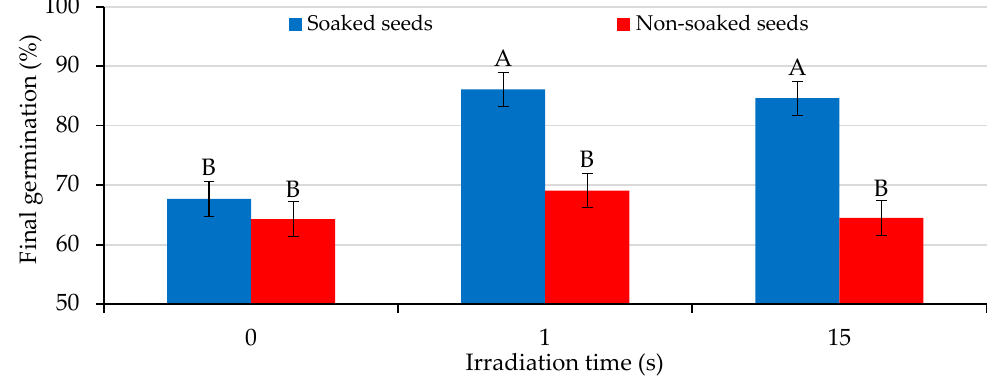
Figure 4. Logistic model adjusted to the curves of accumulated germination of caper seeds from Different letters in the same column within each factor indicate significant differences ( p ≤ 0.05) according to the Experiment 4. Average values corresponding to the combination of the exposure time of the seeds LSD test. **: significance level p ≤ 0.01, NS: Not significant. ( + ) The standard deviation has been calculated as the to the He-Ne laser irradiation (0, 1 or 15 s) after being soaked in water or not. A 500 mg L − 1 GA 3 square root of the residual mean square. solution was used to wet the substrate.